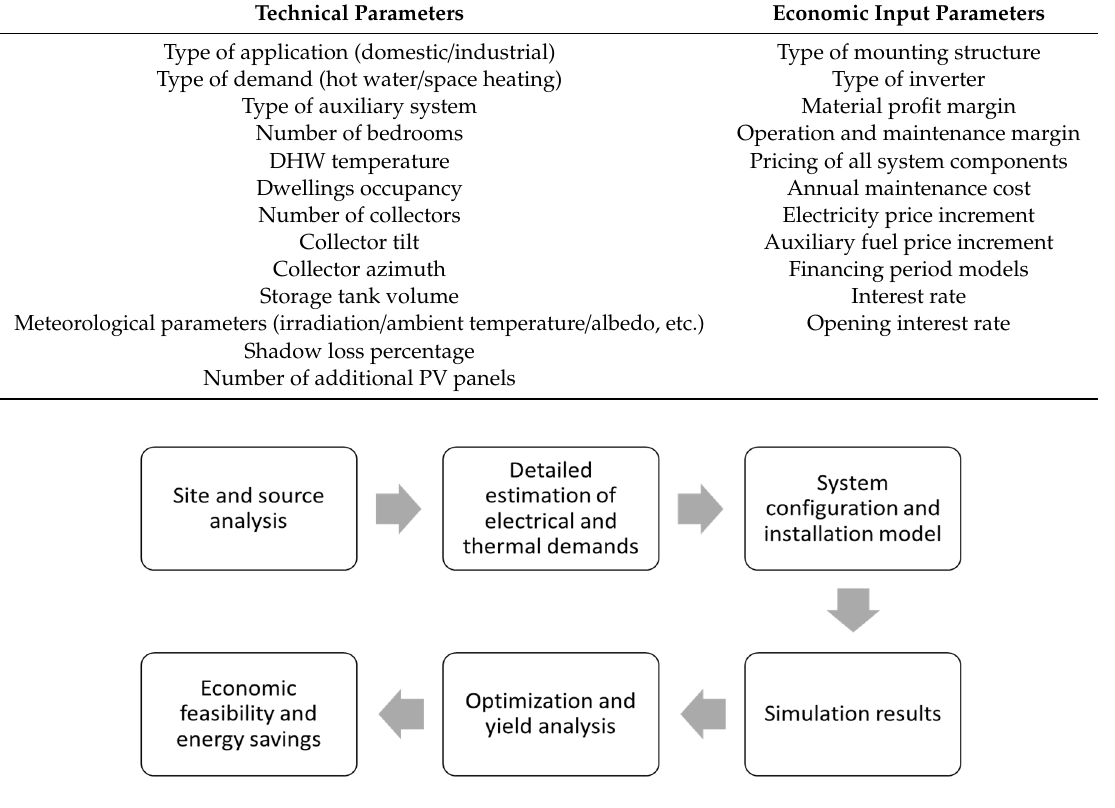
Figure 3. Operation flow of the simulation tool.